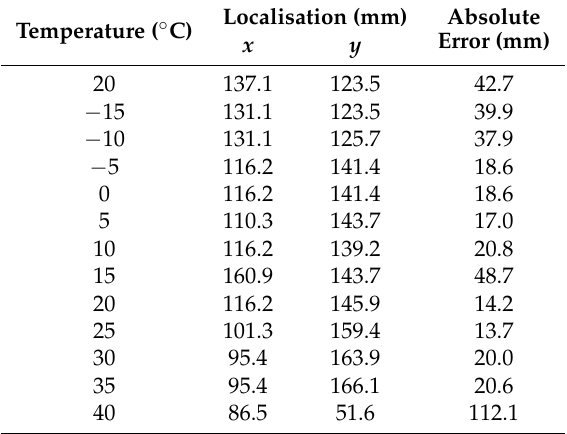
Table 4. BVID localisation error on the SHM layer CFRP plate (300 kHz), actual location (115,160) mm. Baseline recorded at 25 ◦ C with temperature compensated current signal, using 4